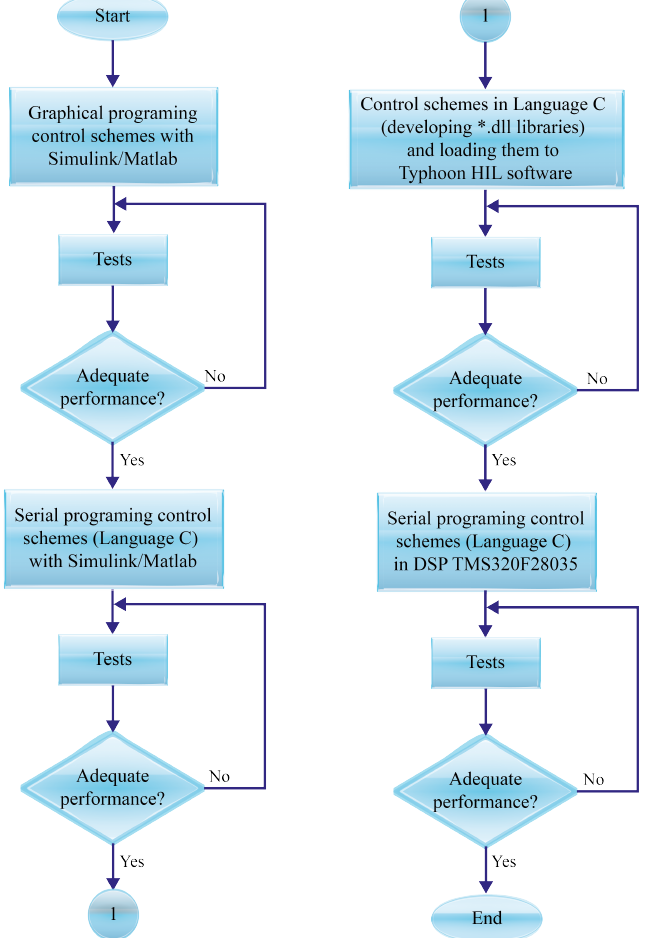
Figure 6. Implementation processes flow